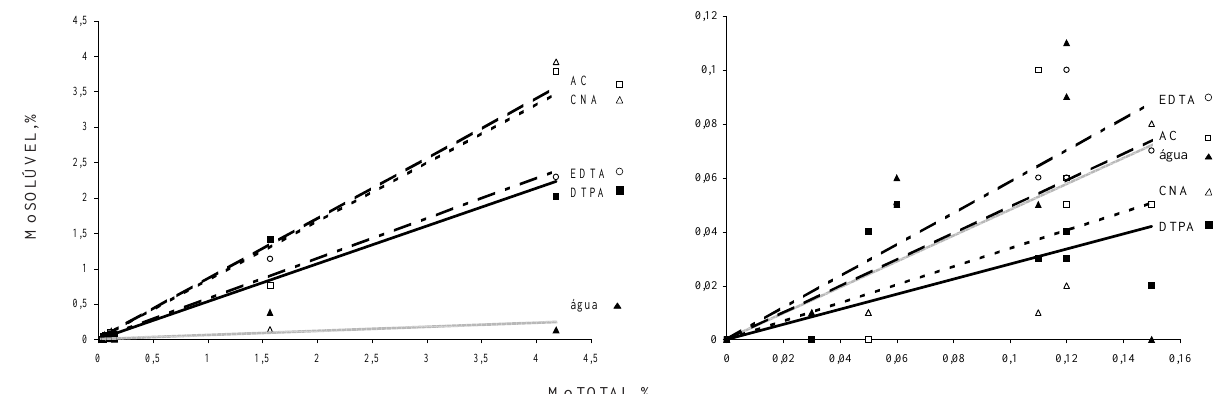
Figura 6. Solubilidade do molibdênio presente em fertilizantes comerciais, nos diferentes extratores, considerando todas as amostras (a) e somente nas amostras com baixo teor do elemento (b).